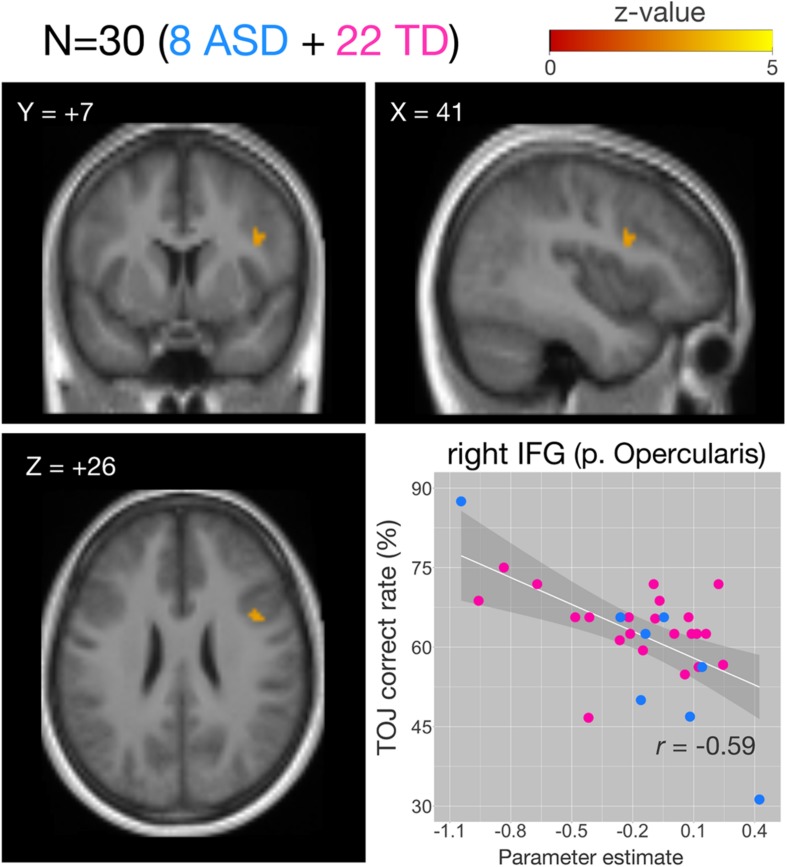
Correlations of functional MRI (fMRI) activation [temporal order judgment (TOJ) > numerosity judgment (NJ)] and correct TOJ performance rates in the right inferior frontal gyrus (IFG) after small volume correction (SVC). The analyses were thresholded at voxel level p < 0.001, uncorrected and cluster corrected with pFWE < 0.05. Significant clusters were mapped on sections [x, sagittal; y, coronal; z axial slices, Montreal Neurological Institute (MNI) coordinates] created from averaged, normalized, T1-weighted image of 30 subjects. The correct TOJ rates are plotted against the extracted SPM parameter estimates from the identified clusters in the right IFG wherein filled circles show individual rates of eight autism spectrum disorder (ASD) (blue) and 22 healthy controls (magenta). Shaded regions represent 95% confidence intervals of the Pearson’s correlation coefficients. FWE, Family Wise Error.